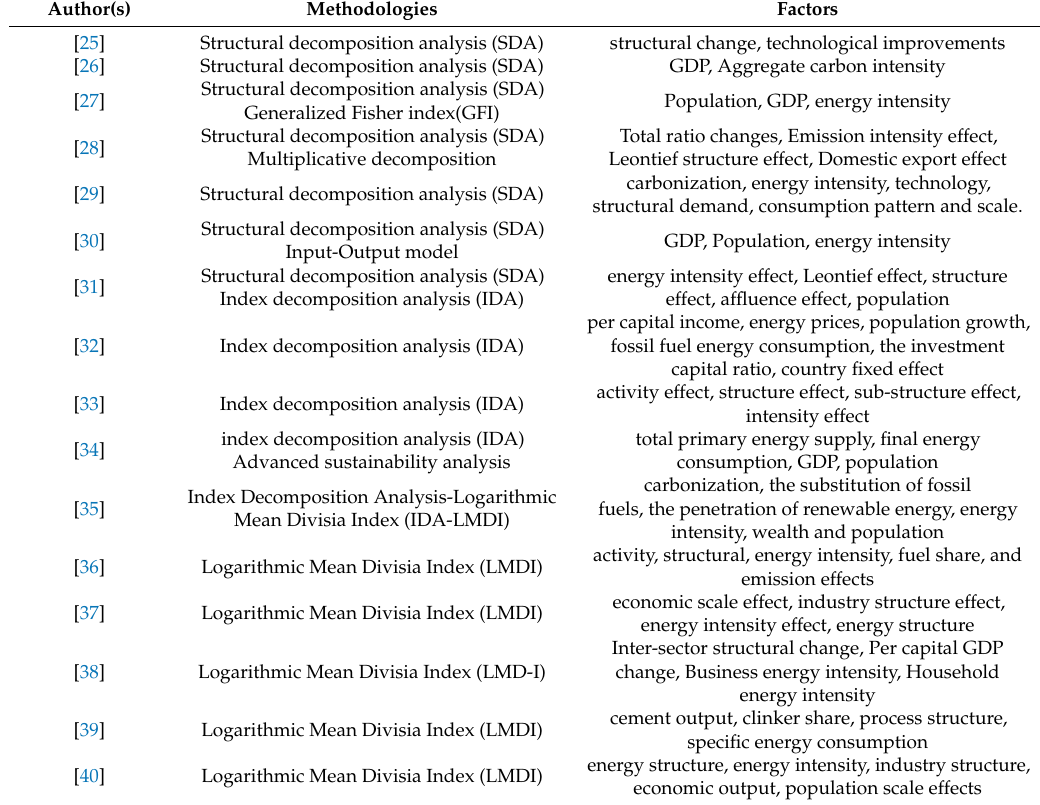
Table 1. Detailed review of the methods of decomposing